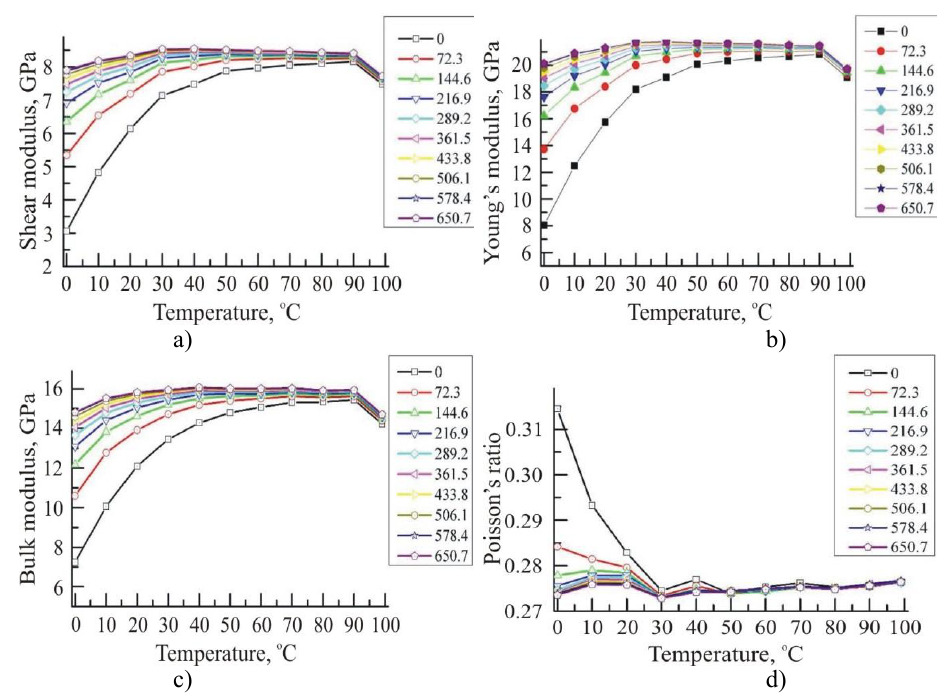
Fig. 4 . Temperature dependencies during 0-672 h: a – shear modulus; b – Young’s modulus; c – bulk modulus; d – Poisson’s